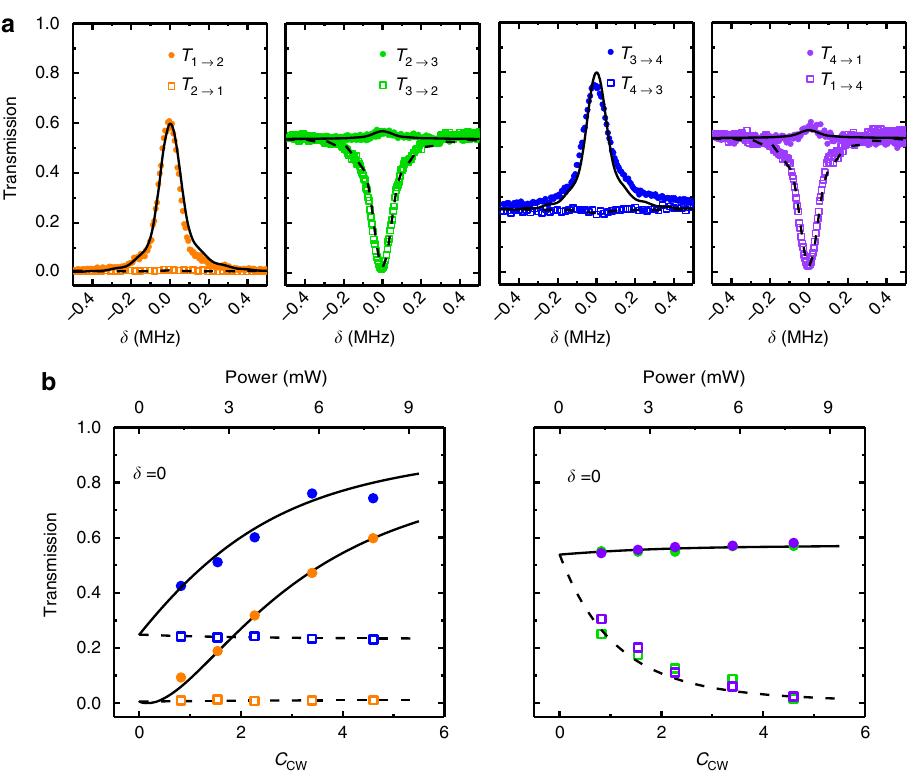
Fig. 2 Demonstration of the circulator function with a red-detuned control fi eld. a Measured port-to-port transmission spectra of the signal around the cavity resonance; the solid circles correspond to T i → i + 1 and the open squares correspond to T i + 1 → i . The incident control power is 7.8 mW, corresponding to C = 4.6. b The transmittance obtained at δ = 0 versus C cw ω π = 90.47 MHz, and γ /2 π = 22 m /2